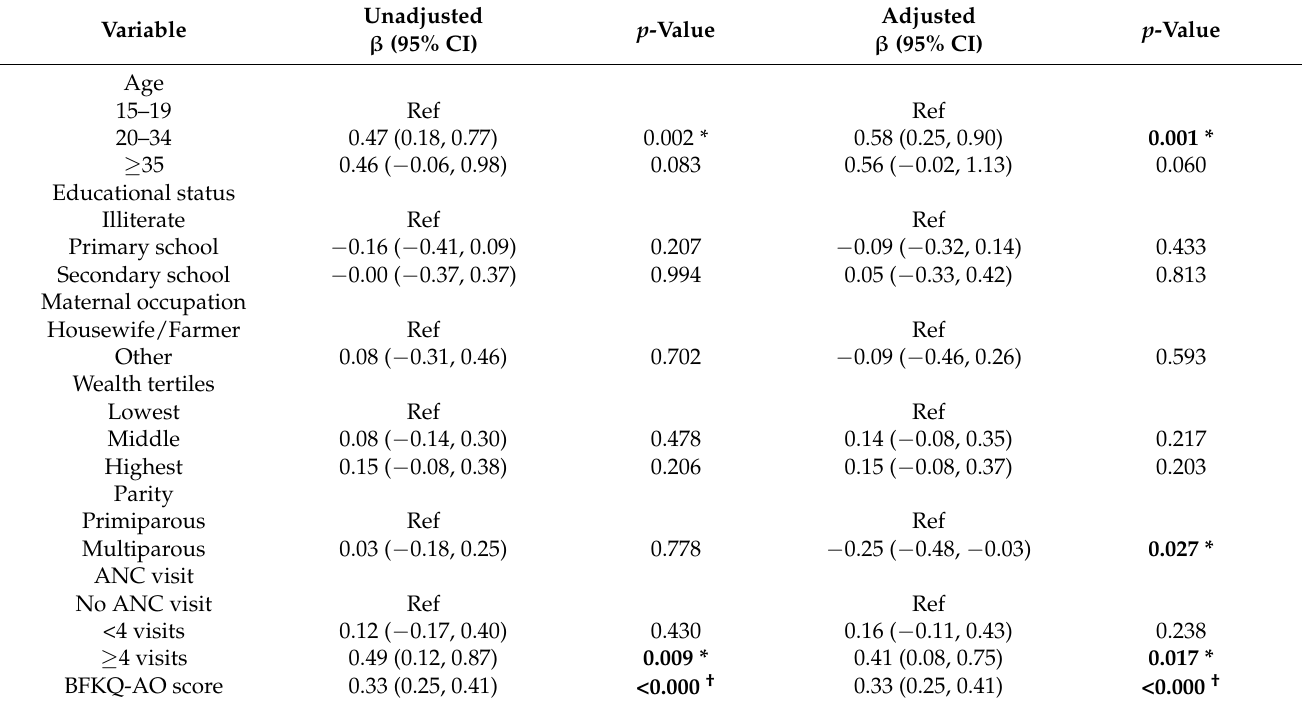
Table 3. Predictors of attitude towards infant feeding using the IIFAS-AO among 468 pregnant Ethiopian rural women participating in breastfeeding education and support intervention